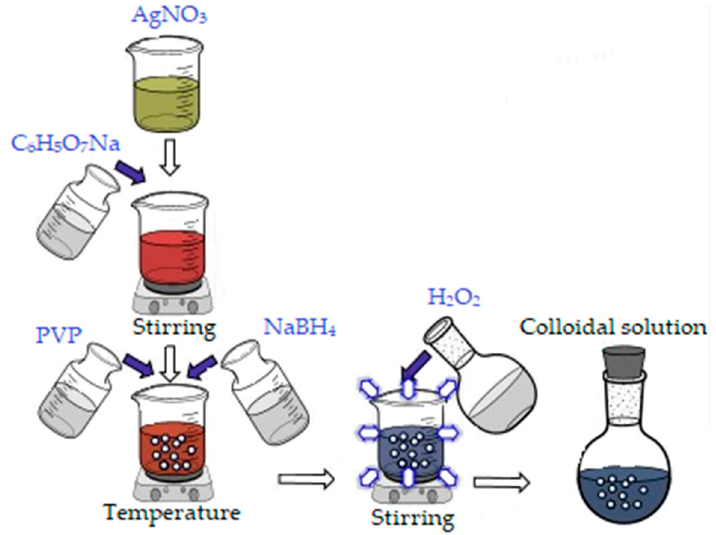
Figure 1. Synthesis of silver nanoparticles.